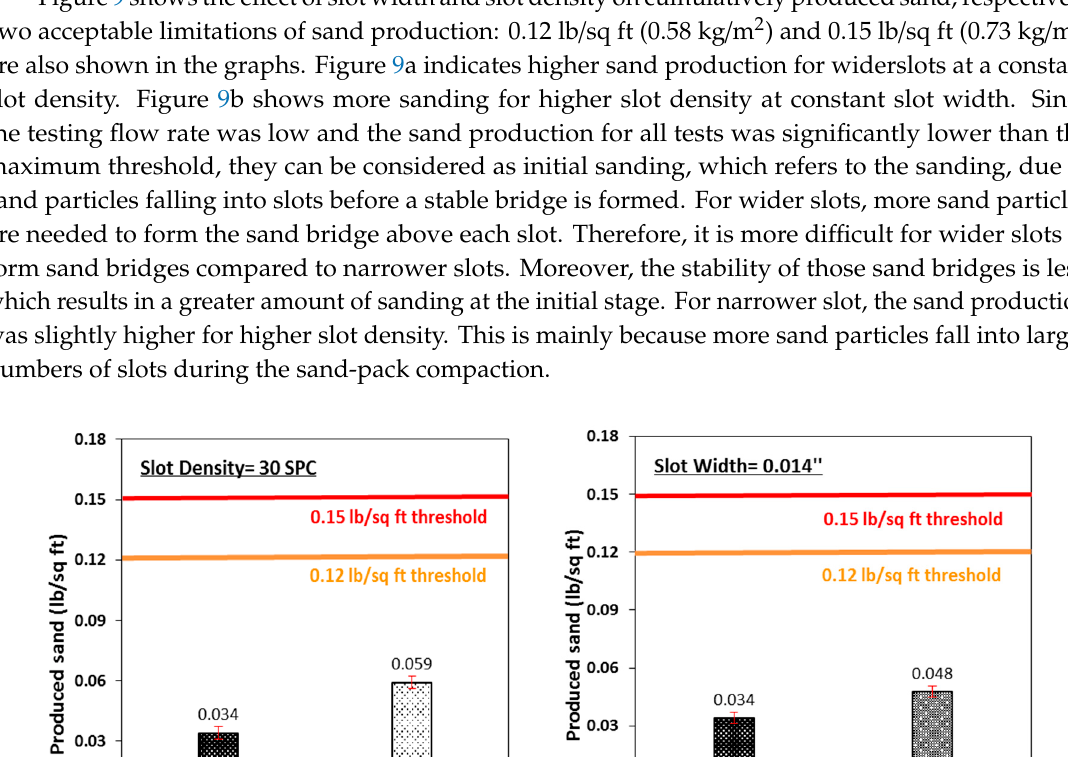
Table 3. Testing matrix to study the performance of slotted liners with constant open flow area (OFA). Slot Width (thou) SPC OFA (%)